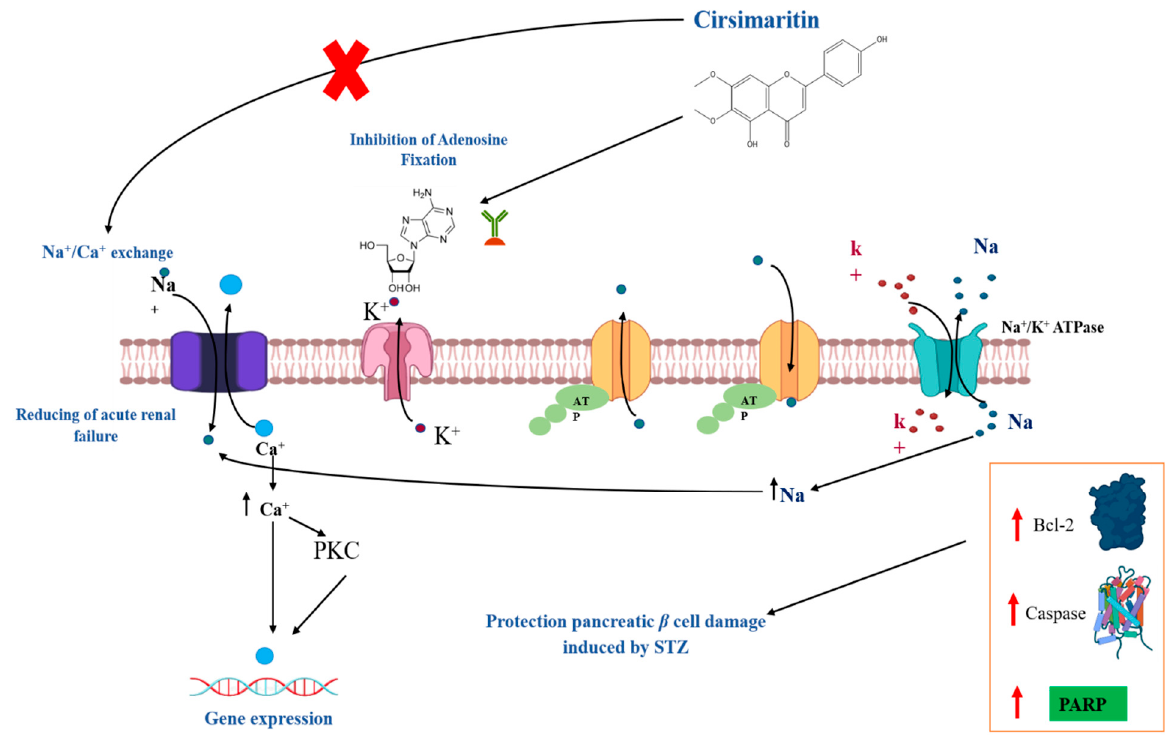
Figure 4. Antidiabetic mechanisms of cirsimaritin.